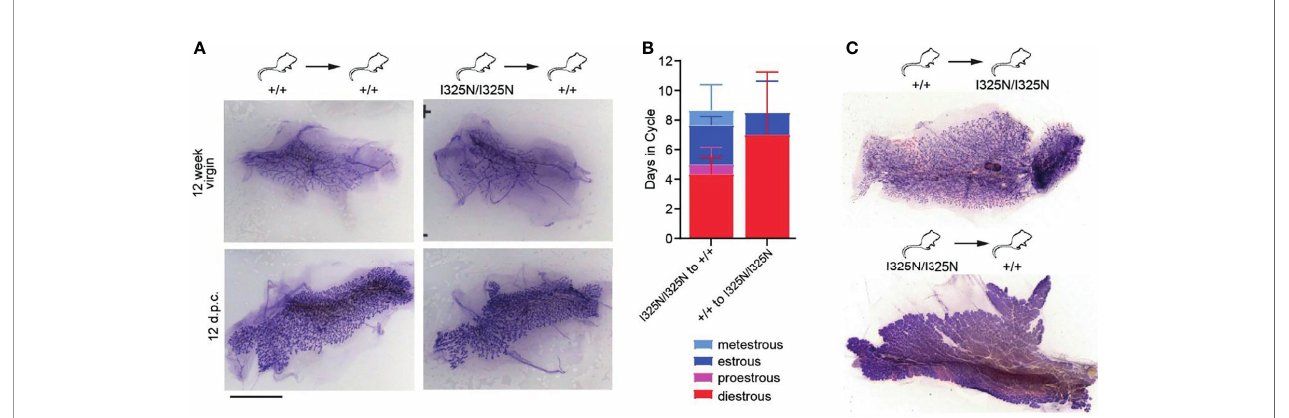
FIGURE 3 | Transplantation of I325N mammary tissue or ovaries into WT recipients rescues mammary development and esterous cycling. (A) Representative whole mounts of mammary gland at 8 weeks following mammary epithelial transplants from wild-type (left column) or I325N homozygous (right column) donors into wild- type recipients. Whole mounts were assessed from virgin mice (top row – 12-week virgin) or following pairing with a wild-type male and 12 days post coitum (d.p.c.). Scale bar = 5mm. (B) Average days spent in each cycle-stage from wild type mice receiving a Tnfaip3 I325N/I325N ovary transplant or Tnfaip3 I325N/I325N mice receiving a wild-type ovary. Diff-Quick stain of cervical smears was to determine cycle-stage. (C) Representative whole mount of mammary glands 8 days post-partum of transplanted female7s in (B) . Scale bar = 5mm. Error bars represent